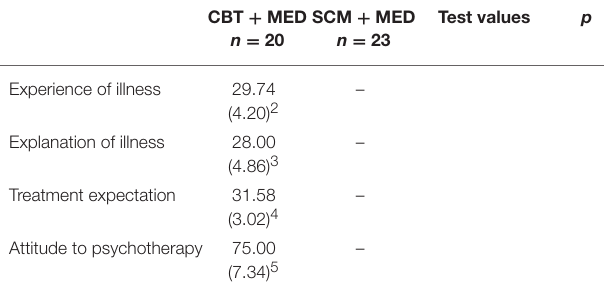
TABLE 2 | Sociodemographic and current clinical characteristics of the patients in the two treatment